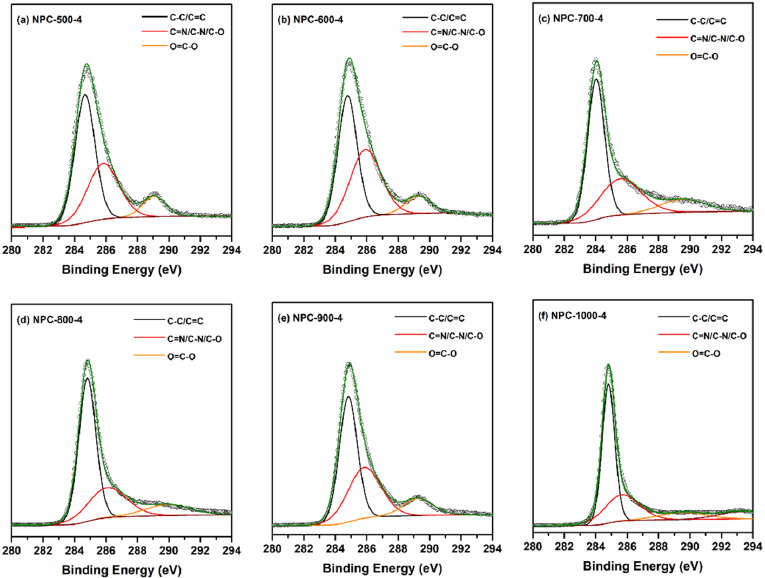
Figure 3. C1s XPS spectra of NPC-500-4 ( a ), NPC-600-4 ( b ), NPC-700-4 ( c ), NPC-800-4 ( d ), NPC-900-4 ( e ) and NPC-500-4 ( f ).